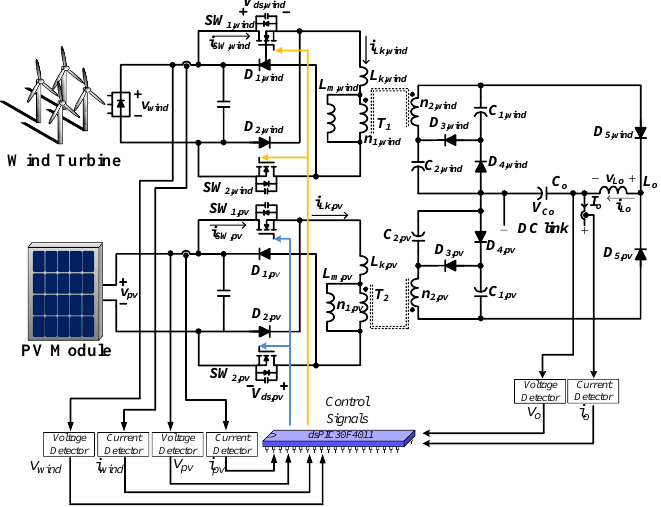
Figure 1. The configuration of the presented dual-input photovoltaic-wind converter (DIPWC).